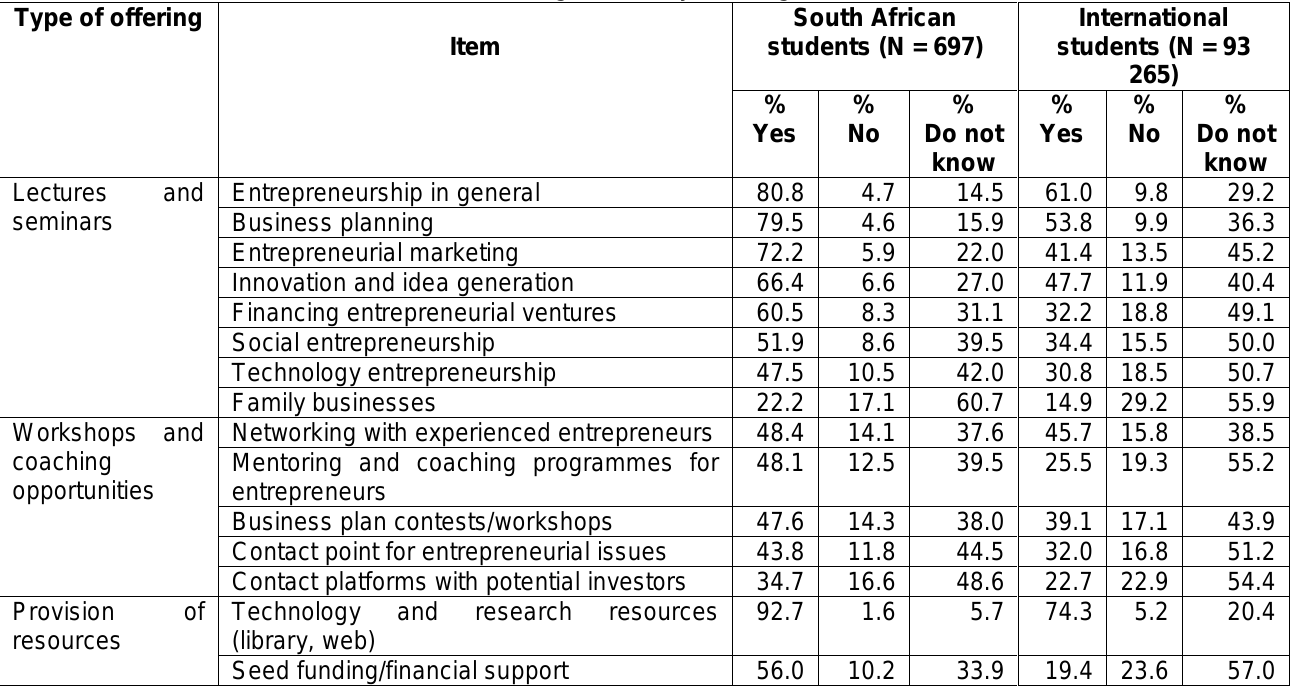
Table 2 Students’ awareness of existing university offerings